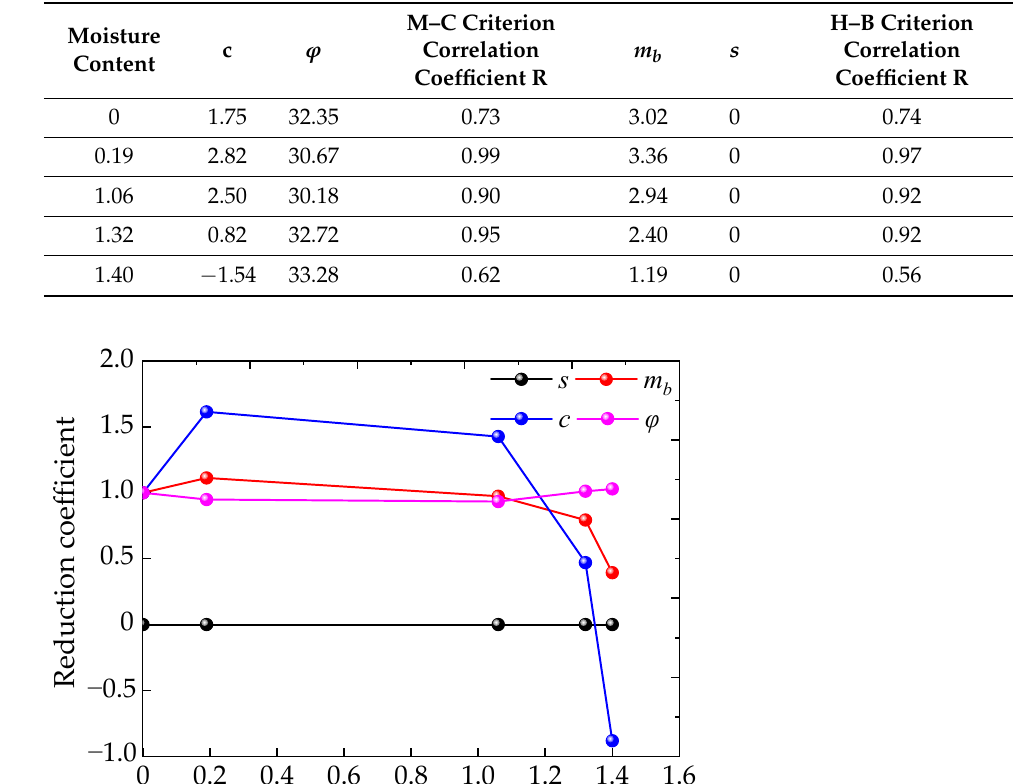
Table 3. Peak strength fitting coefficient of the yield criterion.